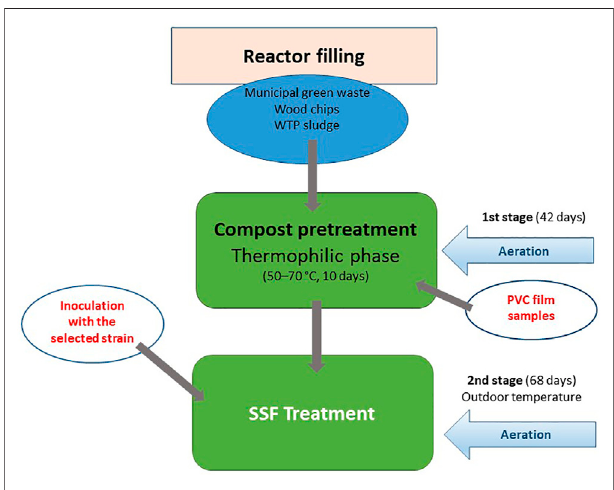
FIGURE 1 | Schematic diagram of two-stage pilot scale, aerobic degradationofPVC fi lmscarriedoutinJanitesKS1.2andAK2.0reactors.For details see section 2.4